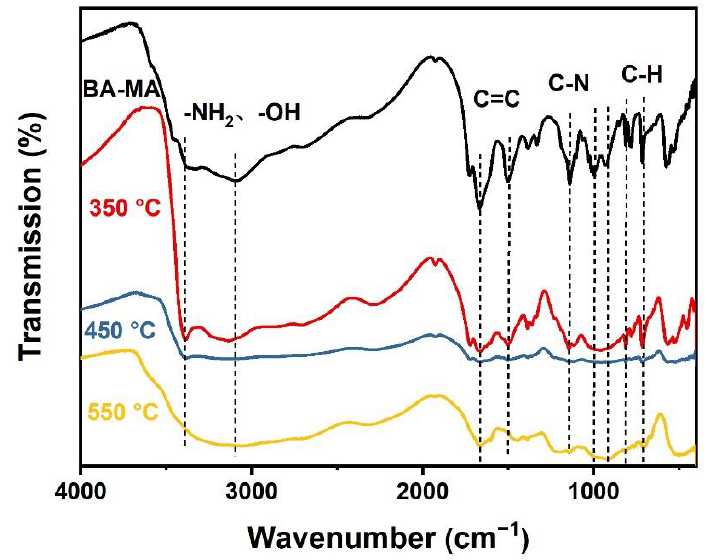
Figure 13. FTIR spectra of pyrolysis products for BA-MA at different temperatures in a tube furnace.